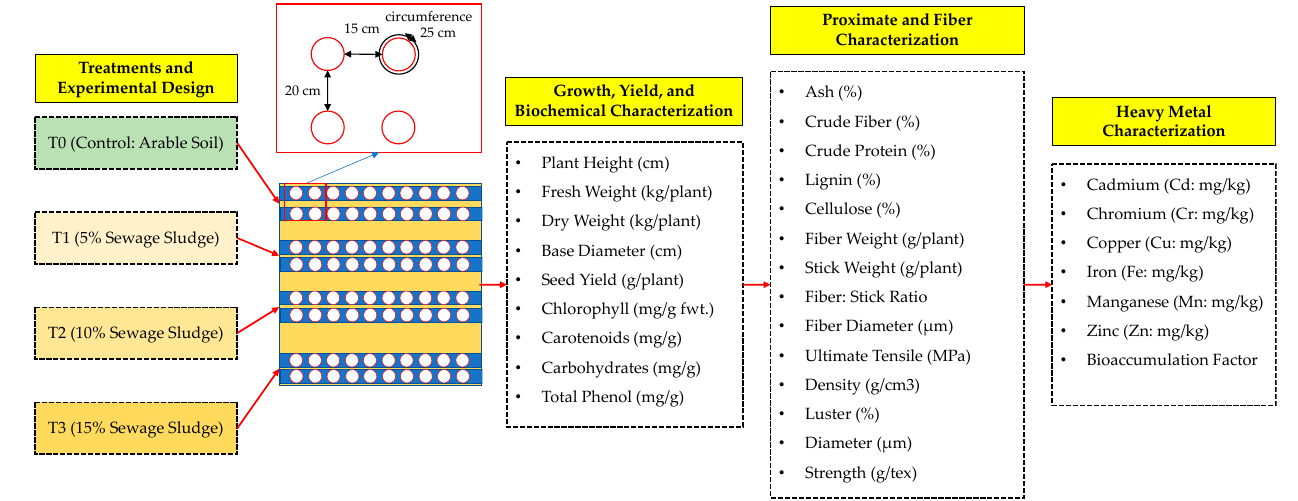
Figure 1. Experimental layout for the cultivation and characterization of dhaincha ( S. bispinosa ).